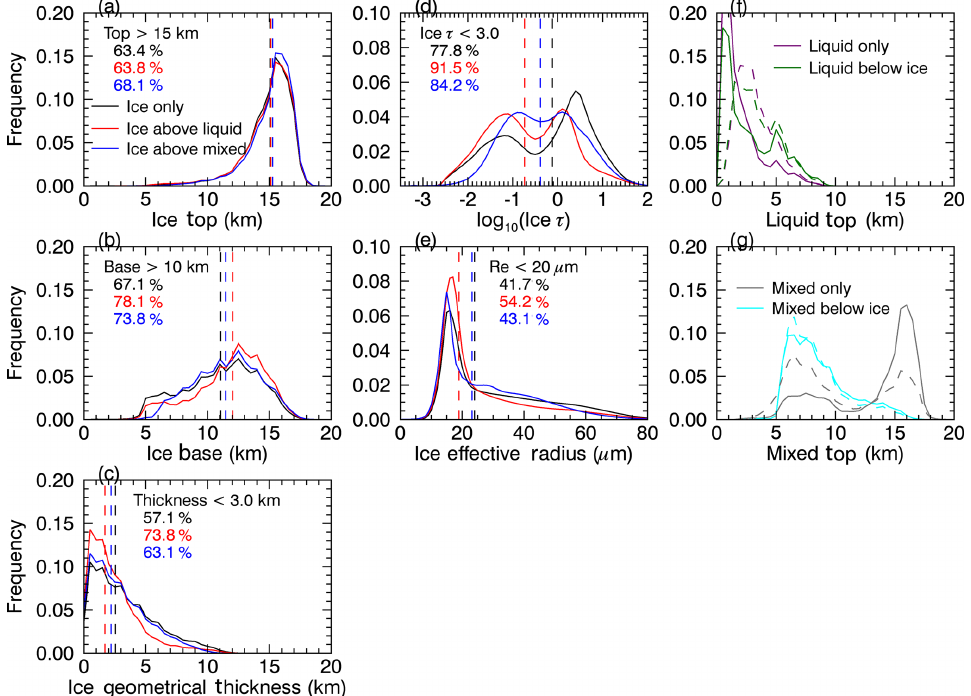
Figure 6. Annual PDFs of (a) cloud top, (b) base, (c) geometric thickness, (d) optical depth, and (e) effective radius for ice clouds including both ocean and land. The vertical dashed lines in (a) – (e) indicate the median values of the PDFs; (f) cloud top for liquid-only cloud and the liquid below ice and (g) cloud top for mixed-only and the mixed cloud below ice. In (f) and (g) , solid and dashed curves are for ocean and land, respectively. Cloud top and base bins adopt an interval of 0.5km. Ice τ and R e bins use an interval of 0.1 on a log scale and 1µm,